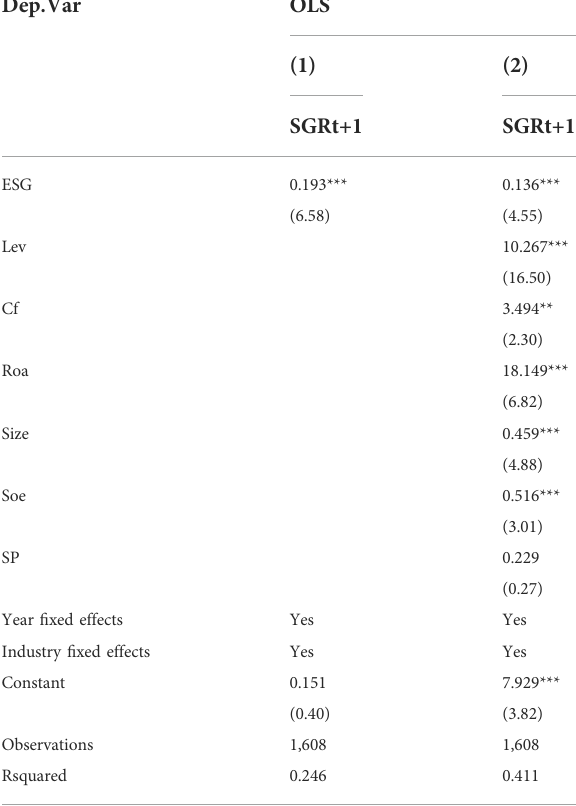
TABLE 4 Impact of ESG disclosure and corporate sustainable growth: benchmark regression.